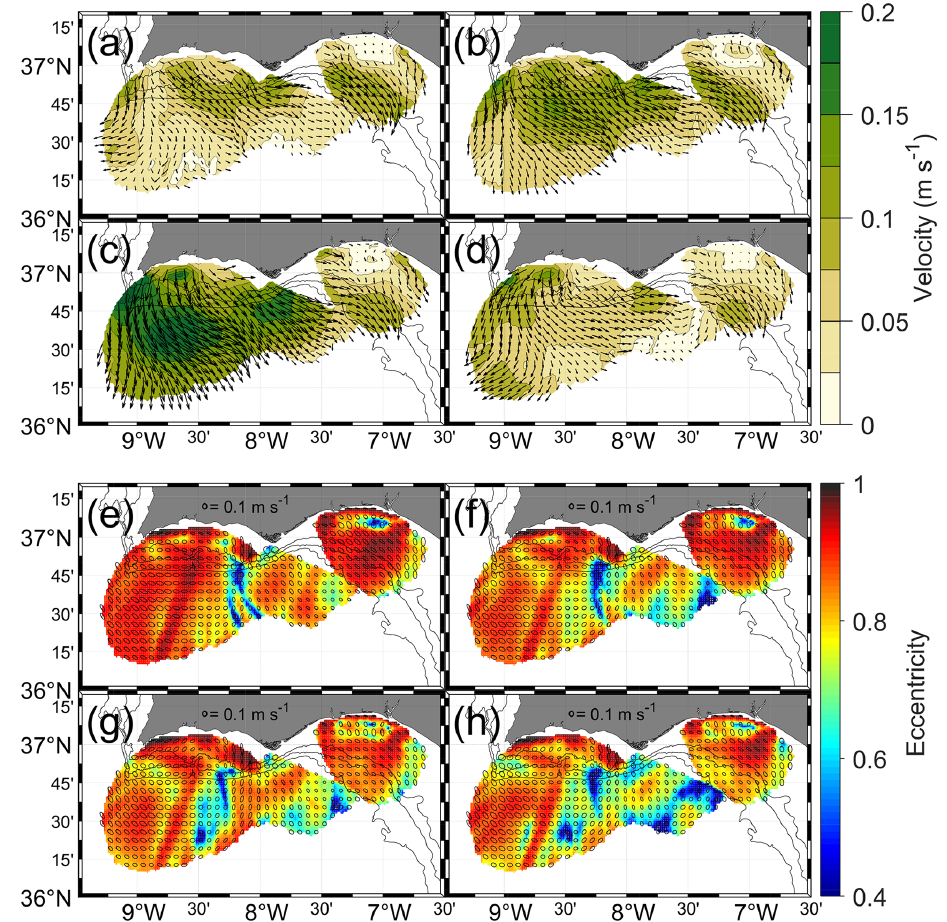
Figure 6. Seasonal mean HFR currents and standard deviation with eccentricity as colour maps in (a, e) winter, (b, f) spring, (c, g) summer and (d, h) autumn for the period February 2016–October 2020. For clarity, the ellipses and arrows are represented every four grid